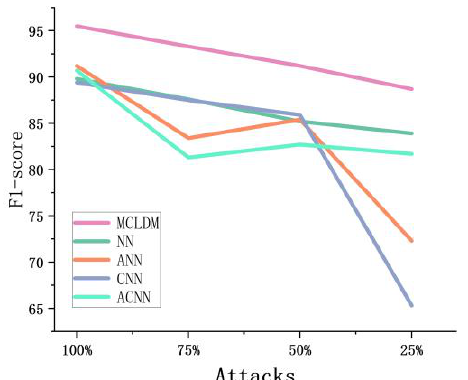
Figure 7. F1-score values of MCLDM, NN, ANN, CNN, and ACNN with the number of attacks in the CICIDS2017 dataset.